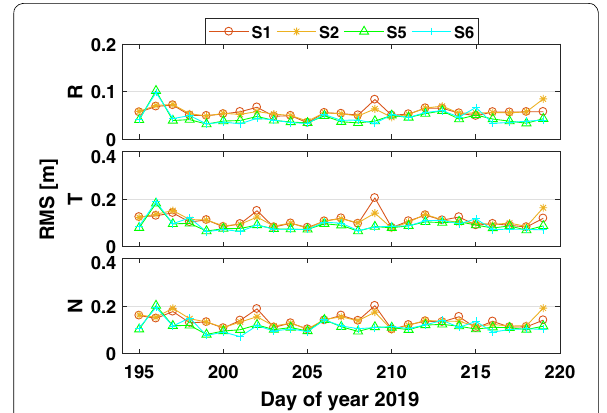
Fig. 2 Average orbit accuracy of each POD arc of